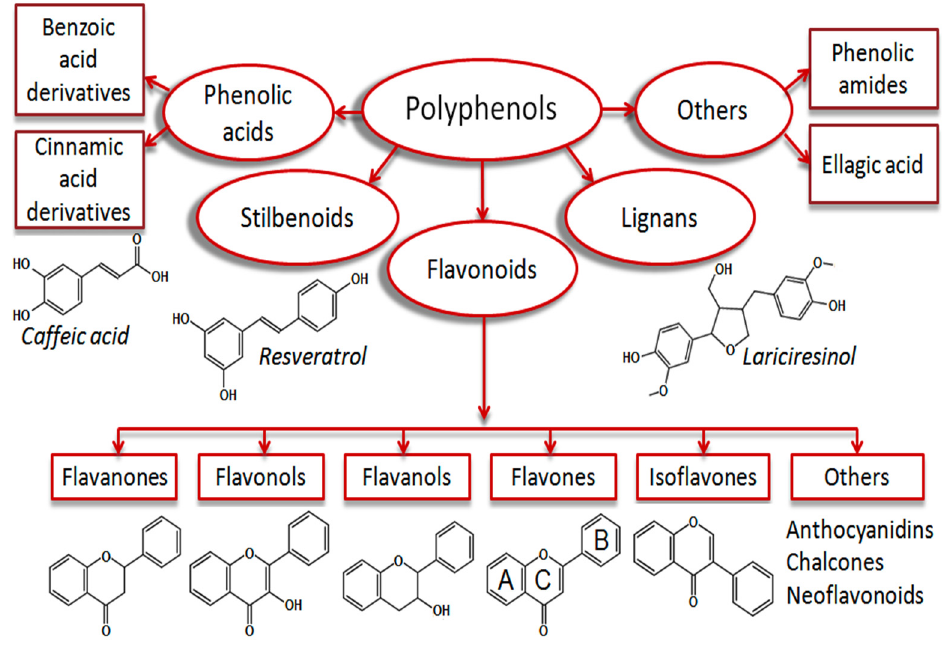
Figure 1. Plant phenolic compound breakdown. This Figure is reproduced from Ref. [23]. Copyright 2019 (Dirimanov & H ӧ gger, 2019).